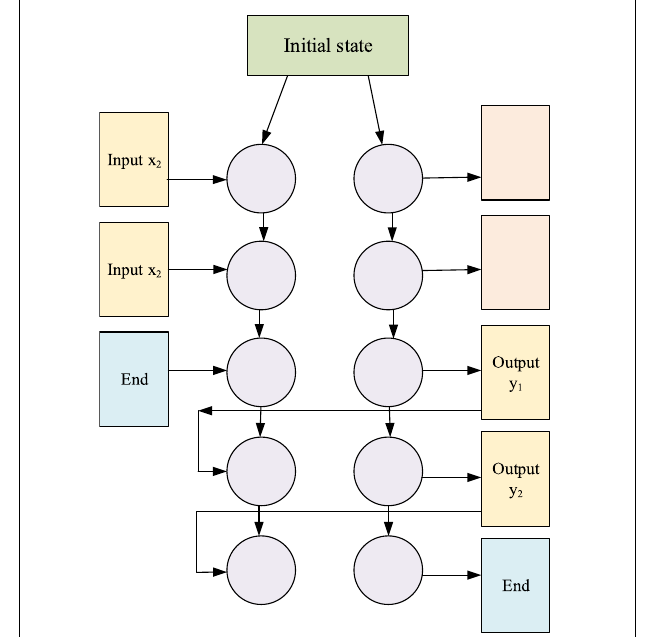
FIGURE 7 | Double-layered RNN